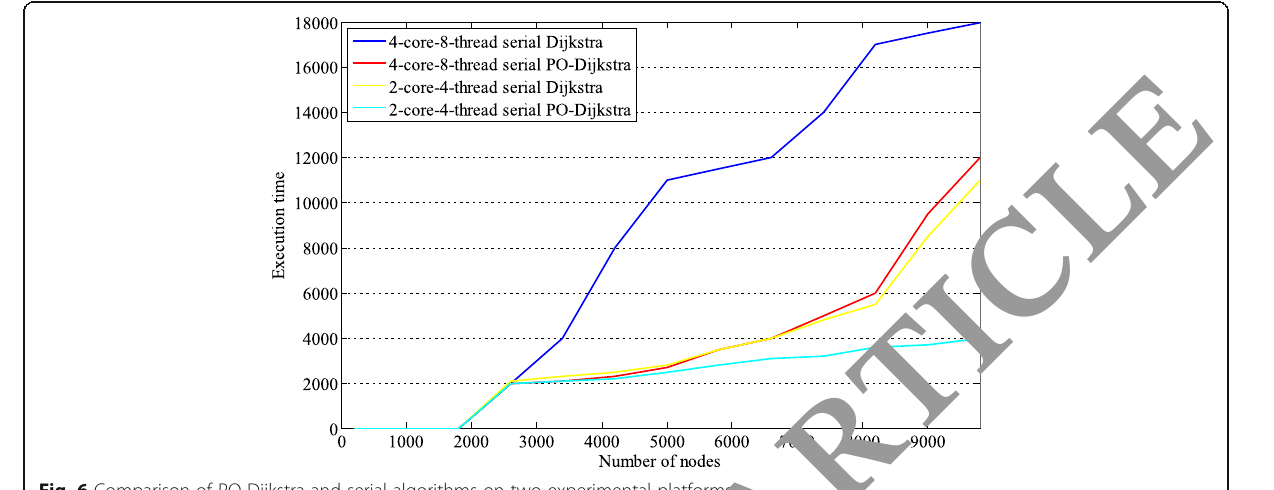
Fig. 6 Comparison of PO-Dijkstra and serial algorithms on two experimental platforms